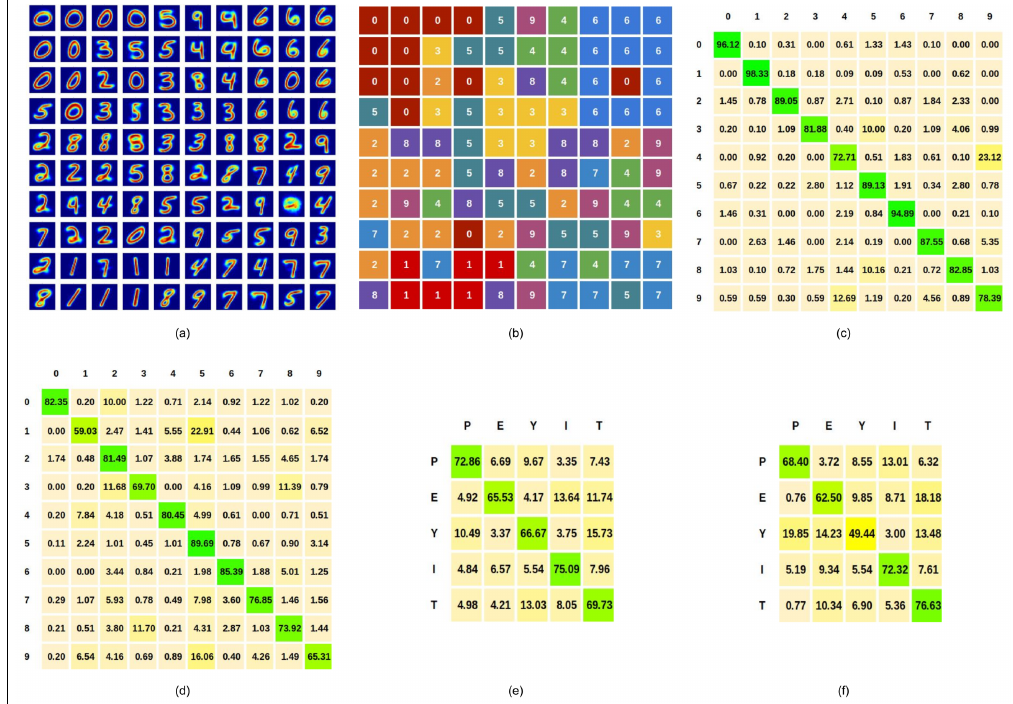
Figure 4. MNIST learning with SOM: ( a ) neurons afferent weights; ( b ) neurons labels; ( c ) confusion matrix; we can visually assess the good labeling from ( a ) and ( b ), while ( c ) shows that some classes like 4 and 9 are easier to confuse than others, and that’s due to their proximity in the 784-dimensional space; ( d ) S-MNIST divergence confusion matrix; ( e ) Dynamic Vision Sensor (DVS) confusion matrix; ( f ) EletroMyoGraphy (EMG) divergence confusion matrix; the interesting characteristic is that the confusion between the same classes is not the same for the different modalities, and that’s why they can complement each other. Table 2. Classification accuracies and convergence/divergence gains (bold number represent the best results in the table). Digits Hand Database